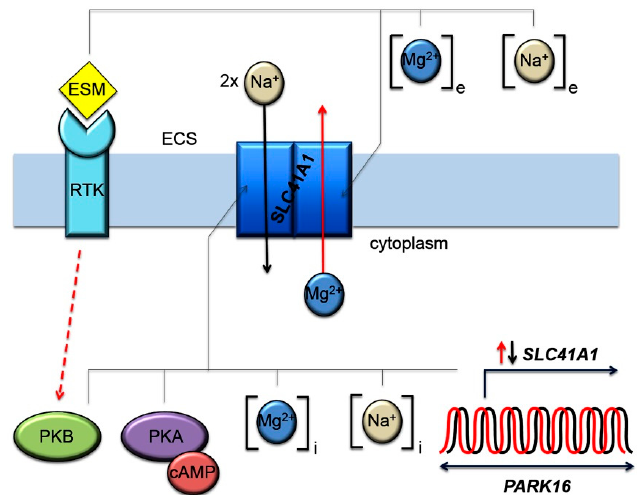
Figure 1. Factors regulating activity of Na + / Mg 2 + exchange via SLC41A1 (A1). Among the most prominent intracellular A1 activity-regulating factors belong: cAMP-dependent PKA (activator), Akt/PKB (inhibitory effect via activation of cAMP degradation by phosphodiesterase 3b (PDE3b)) [14], transcription activity of A1 , and intracellular concentrations of Na + and Mg 2+ . The regulation by extracellular factors such as concentrations of Na + and Mg 2 + in the extracellular fluid and extracellular signaling molecules / hormones (ESM; e.g., insulin, neuritin, PDGF, EGF), which stimulate various receptor tyrosine kinases (RTK) are also equally important. RTK further activate adjacent signaling cascades (represented by dashed red arrow) that merge together in PI3K–Akt / PKB signaling nodes [16]. (ECS) extracellular space; the short red arrow ( ↑ ) indicates increased and the short black ( ↓ ) decreased experession of A1 .